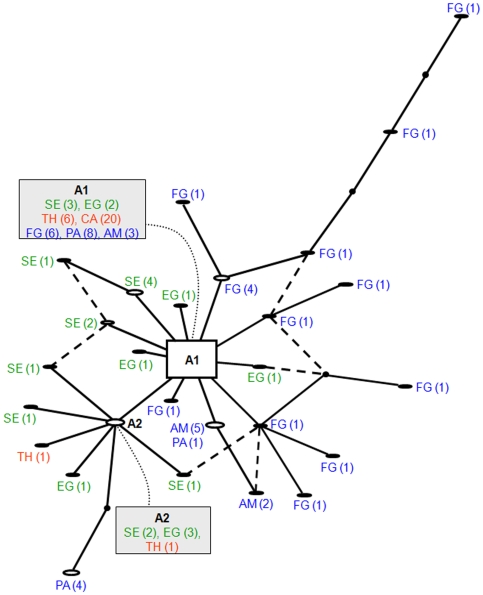
TCS network for the pfserca gene of Plasmodium falciparum.Each distinct haplotype is represented by an oval with size proportional to its frequency (in parenthesis). Mutational steps are represented by lines. Dots connecting lines represent putative haplotypes that were not sampled. Dashed lines refer to reticulations corrected according to Crandall et al. [38]. Colours correspond to each continent sampled: blue - America (AM: Amazonas; FG: French Guiana; PA: Para), green - Africa (EQ: Equatorial Guinea; SE: Senegal), red - Asia (CA: Cambodia; TH: Thailand).